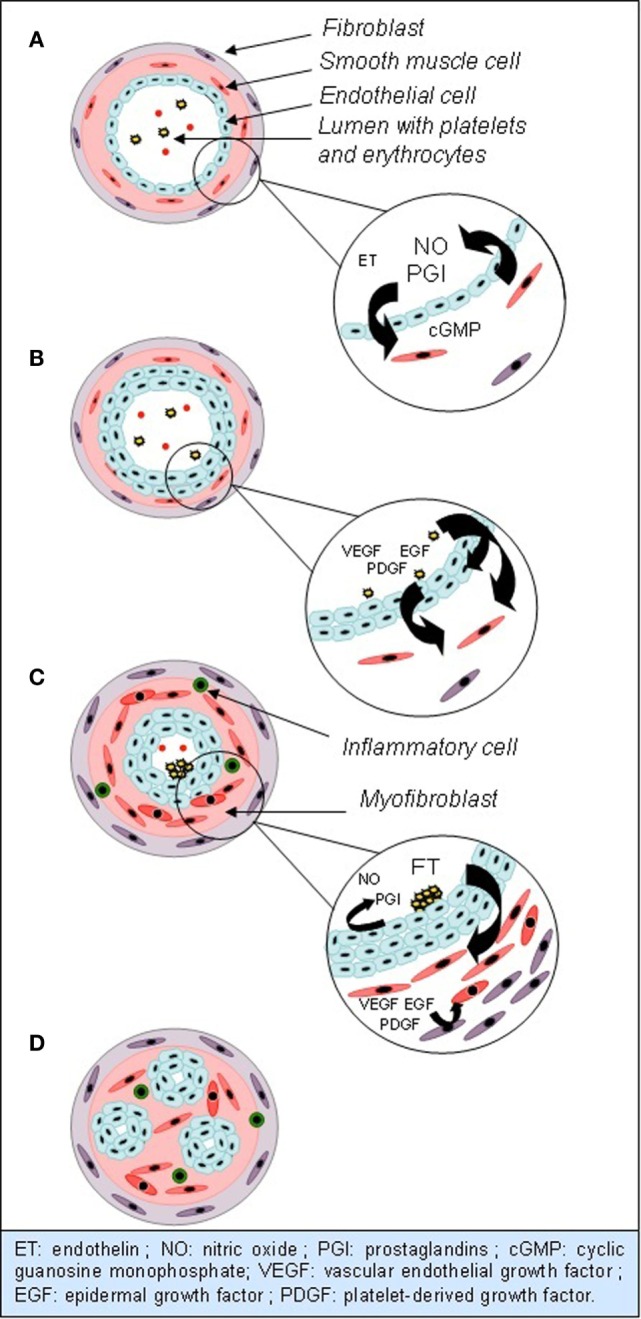
Evolution of anatomical and functional abnormalities in small arterioles in PAH. (A) Normal vessel: vasodilation is predominant, by NO and PGI. (B) Hypertrophy and hyperplasia of endothelial cells, mediated by growth factors. (C) Hypertrophy and hyperplasia of smooth muscle cells and fibroblasts. Extravasation of inflammatory cells. Endothelial dysfunction and clots formation. (D) Plexiform lesions.